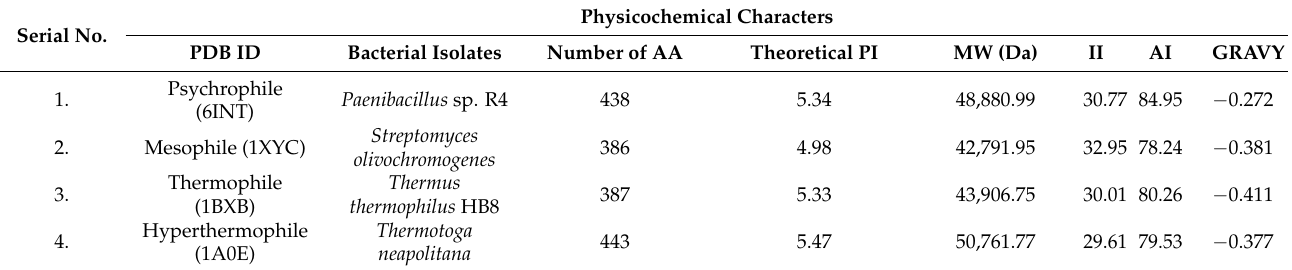
Table 1. Comparative physicochemical characteristics of four chosen bacterial xylose isomerase (XI) enzymes from a psychrophile, mesophile, thermophile, and hyperthermophile.